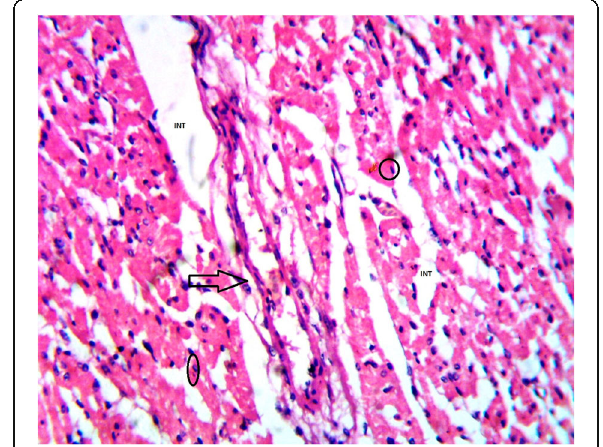
Fig. 2 Heart section of broiler chicken fed 4.0% of PCHM-inclusive diet showing the myocardium composed of the cardiac muscle with peripherally placed nucleus (arrow head) separated by a defined interstitium that is free of inflammatory cells and collections. The cardiac vessels (arrow) appear normal. (H&E ×